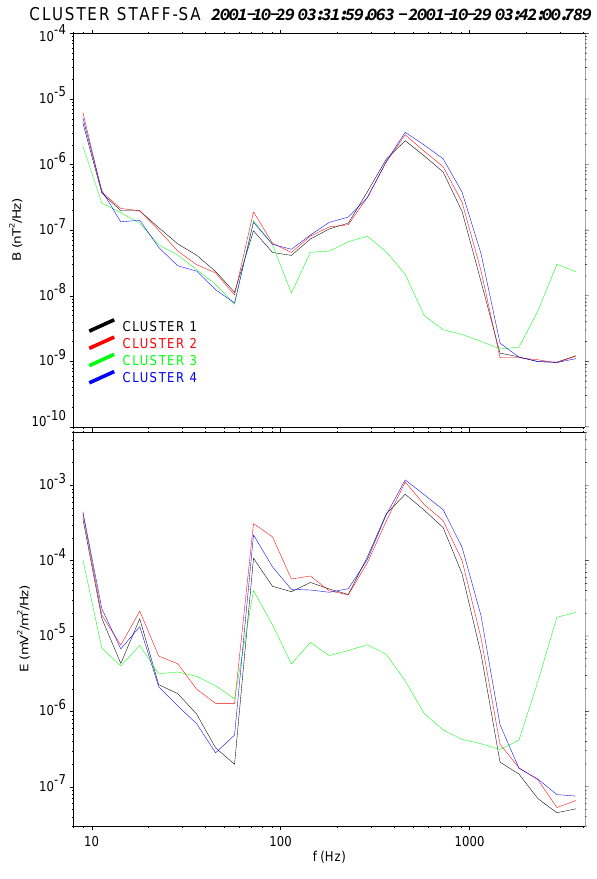
Fig. 8. Same as Fig. 4 for the time interval 03:32–03:42UT.